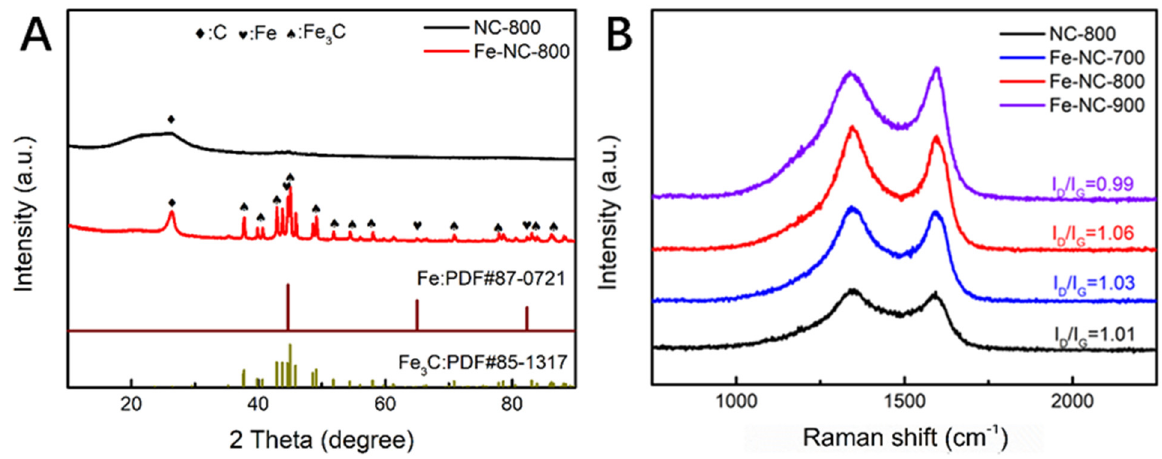
Figure 2. ( A ) the XRD of NC − 800, Fe − NC − 800; ( B ) the Raman spectrum of NC − 800, Fe − NC − 700, Fe − NC − 800, Fe − NC −